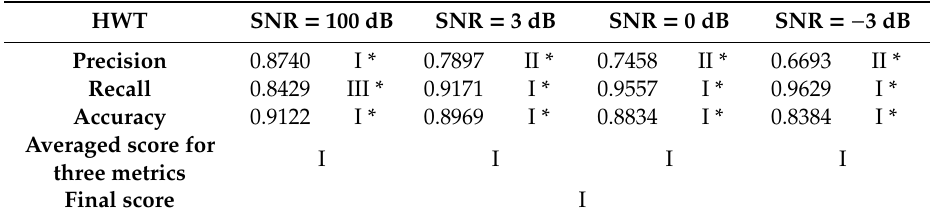
Table 14. Classification results: